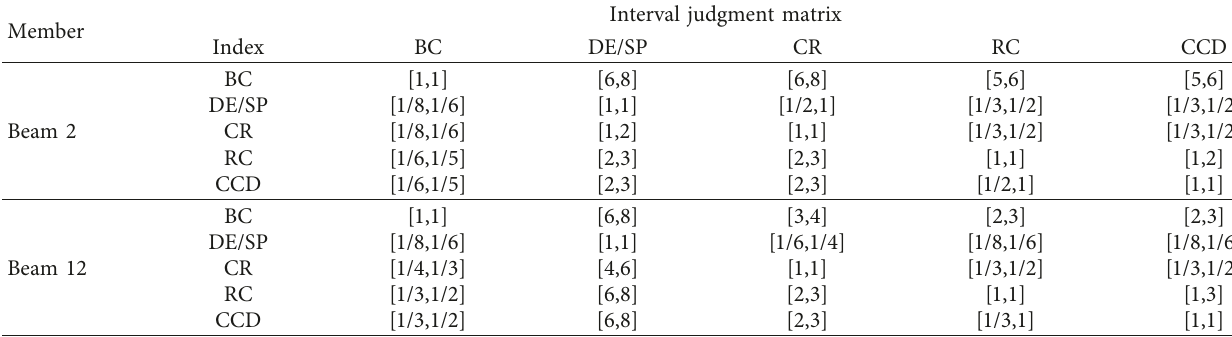
Table 6: The interval judgment matrix of IAHP.